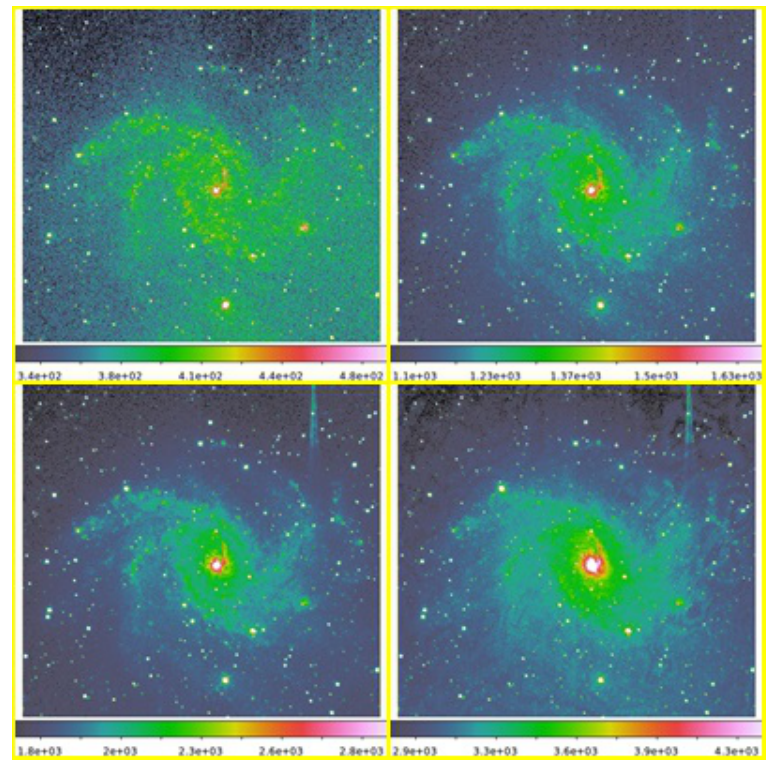
Fig. 1: The BVRI images of NGC 6946 from left to